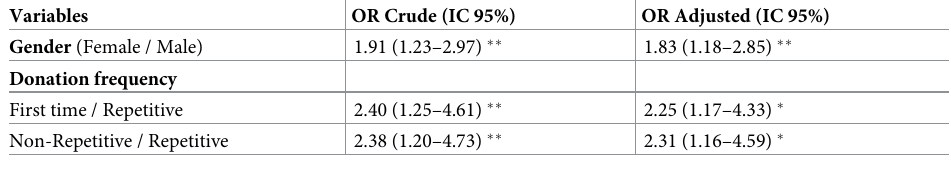
Table 3. Association of the HTLV seroprevalence according to sex and frequency of